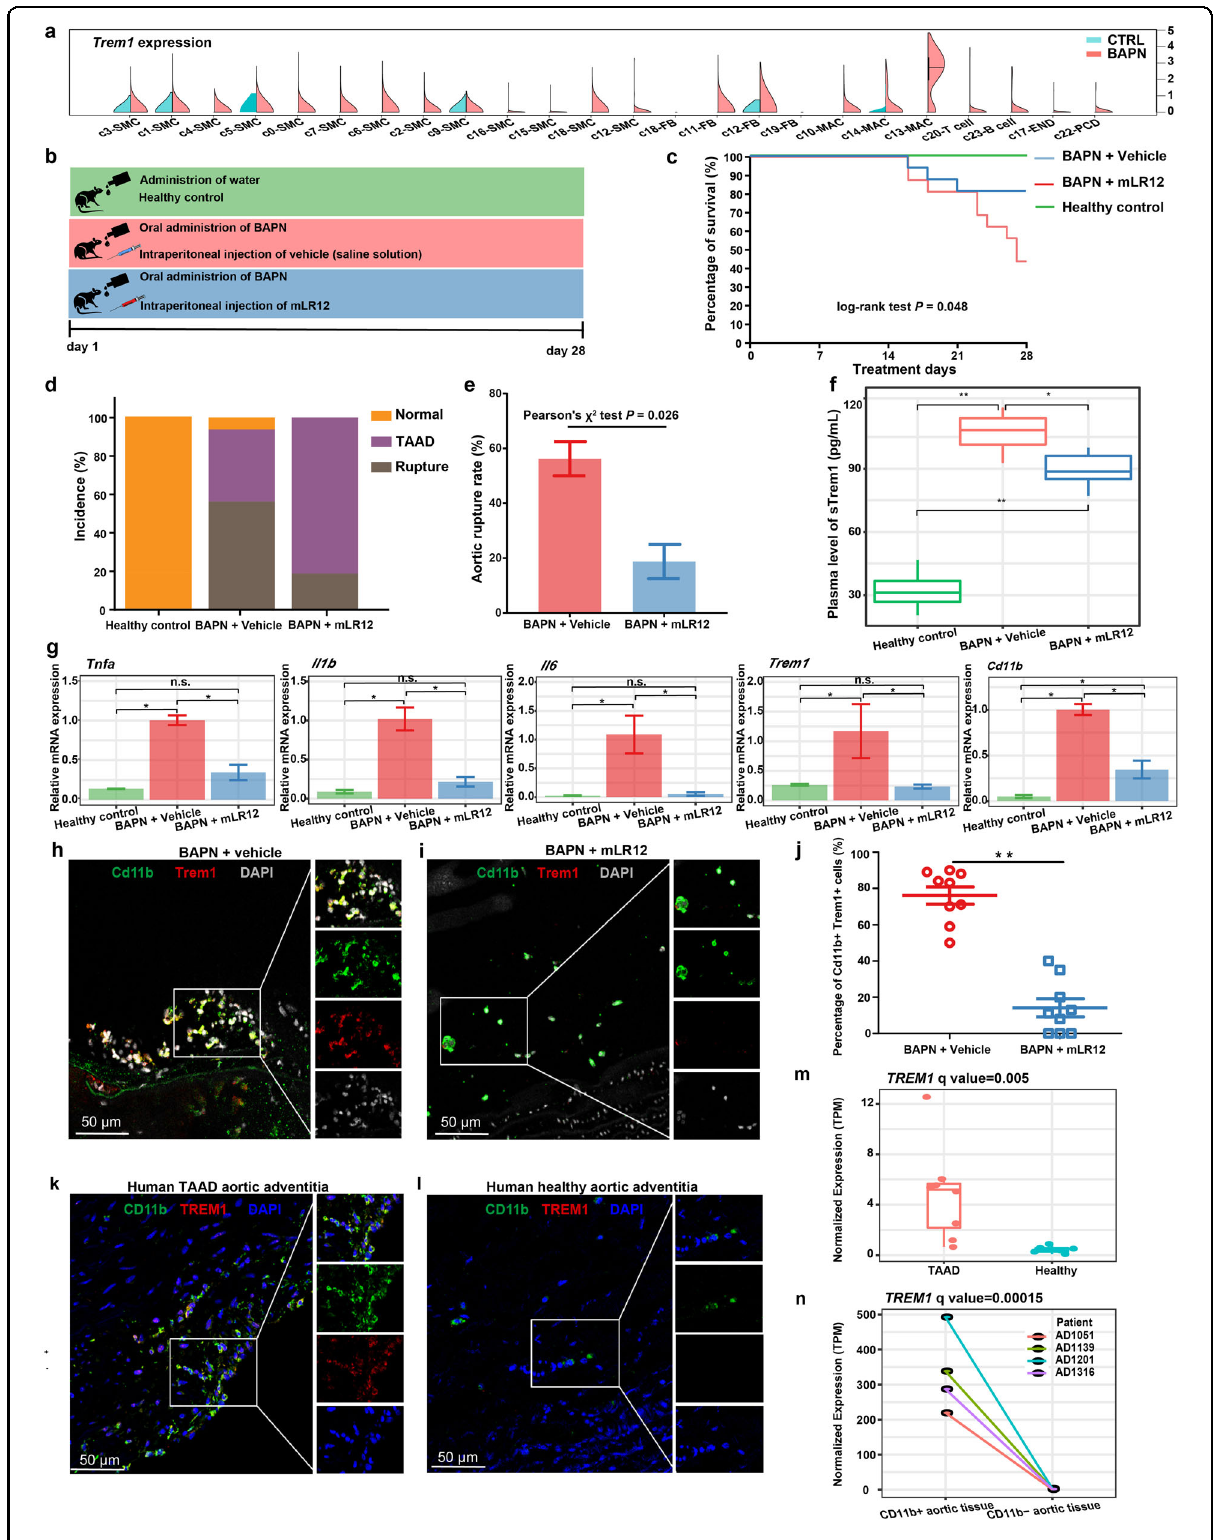
Fig. 7 (See legend on next